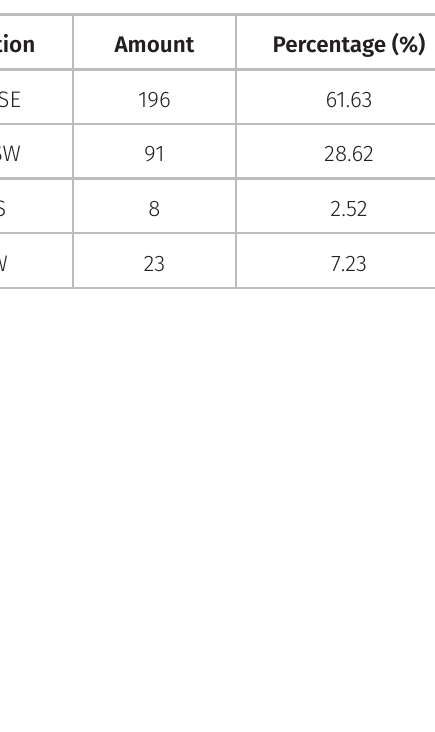
Table IV. Statistical analysis of linear features manually extracted manually on the orthomosaic.